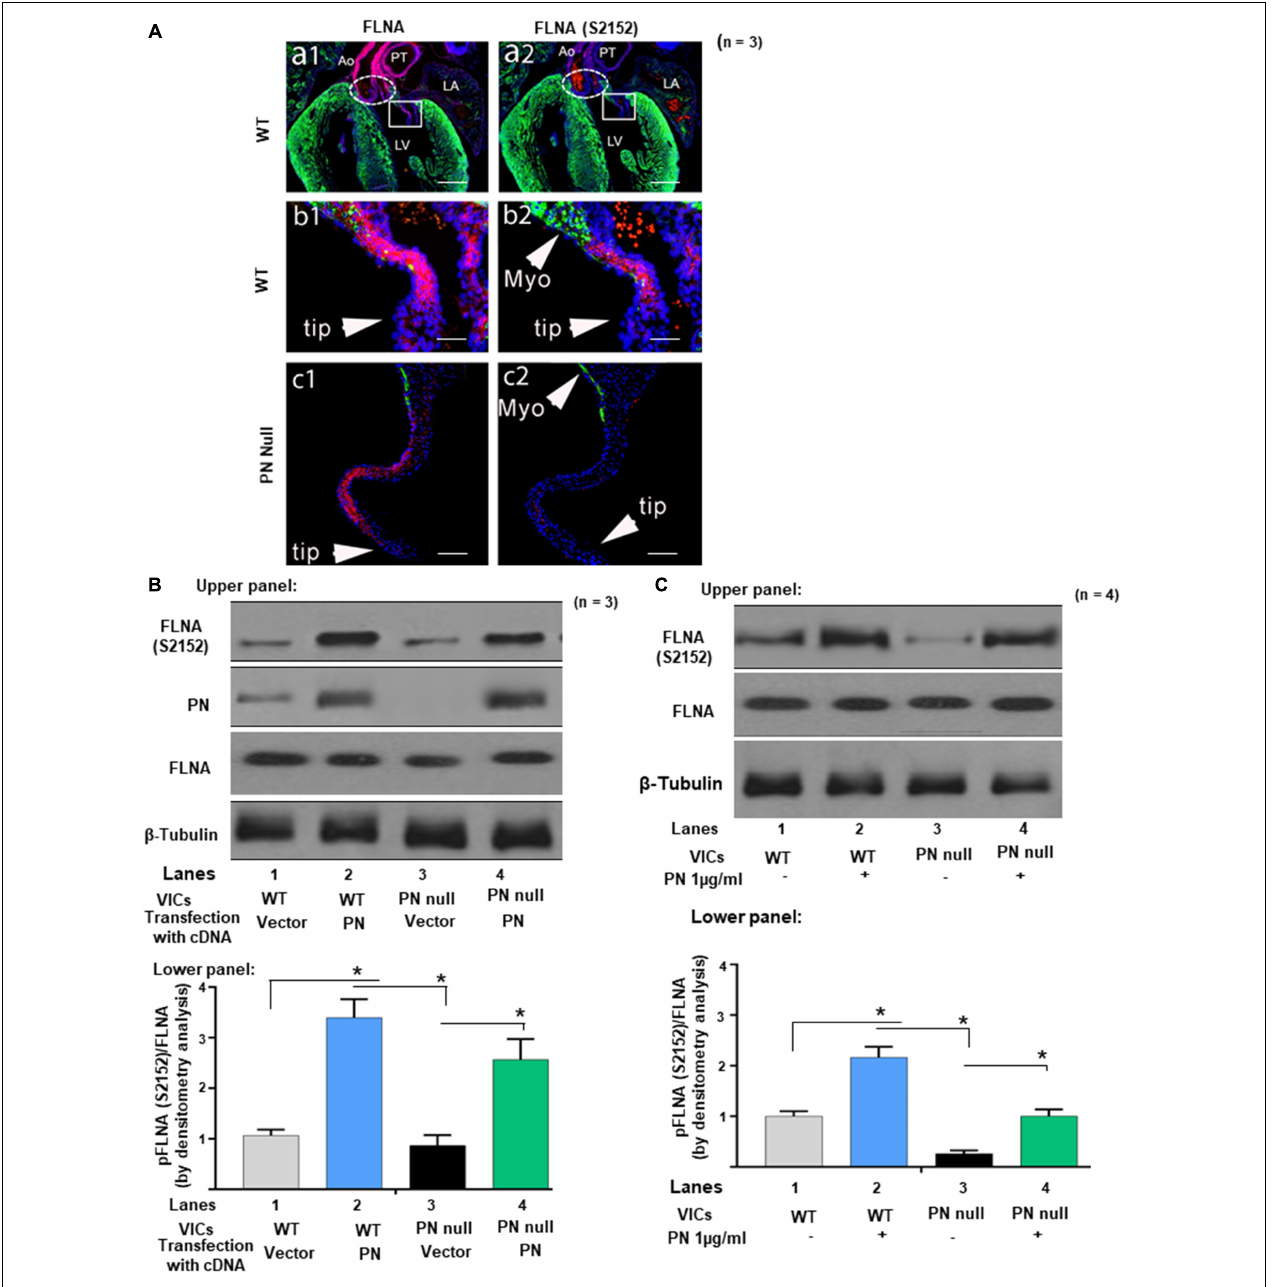
FIGURE 1 | Protein periostin (PN) promotes phosphorylation of filamin A (FLNA) in mitral valve (MV) sections and in valve interstitial cell (VIC) ex vivo cultures. (A) Labels: The elliptic boxes (a1, a2), indicate the aortic valves. The boxes on a1 and a2 indicate the regions of the mitral valve that are shown at higher magnification on the corresponding b1 and b2. LV, left ventricle; LA, left atria; Myo, myocardium; Ao, Aorta; PT, pulmonary trunk. Green color represents immunostaining for myosin heavy chain (MF20). Blue color represents the nuclear staining Hoechst 33342. Contiguous sections from comparable regions from the mitral valve cushions of the same litter of e17.5 WT (b1, b2) or PN null mice (c1, c2) were used for immunostaining with FLNA and phospho-filamin A [p-FLNA (S2152)]. The p-FLNA (S2152) antibody used gave a clear, strong signal in WT mitral valve cushions at e17.5, which correlated closely with the expression of total filamin A (FLNA). In contrast, PN null valves showed significantly decreased p-FLNA. (B) Upper panel: Cell lysates from VICs from e17.5 days were isolated from wild type (WT), and from PN null mice that were transiently transfected with lentivirus encoded with PN cDNA (control, empty vector). They were separated by SDS-PAGE and analyzed by Western blotting (WB) with anti-PN, anti-p-FLNA (S2152), anti-total-FLNA (FLNA), and anti- β -tubulin antibodies. Lower panel: Bars represent densitometric ratios of p-FLNA (S2152)/total FLNA. (C) Upper panel: Cell lysates from the VICs that were isolated from WT, and from PN null mice, were serum starved for 24 h, treated with PN (1 µ g/ml) for 1 h, and analyzed by WB with anti-p-FLNA (S2152) and anti-total-FLNA antibodies. Lower panel: Bars represent densitometric ratios of p-FLNA (S2152)/Total FLNA. Data in “A” is a representative of three experiments. Values in lower panels of (B,C) represent means ± SD; n = 3–6; * p < 0.05 for experimental groups compared with respective control groups. Scale bars in panel (A) 100 µ m. All WBs are representative of three independent experiments.